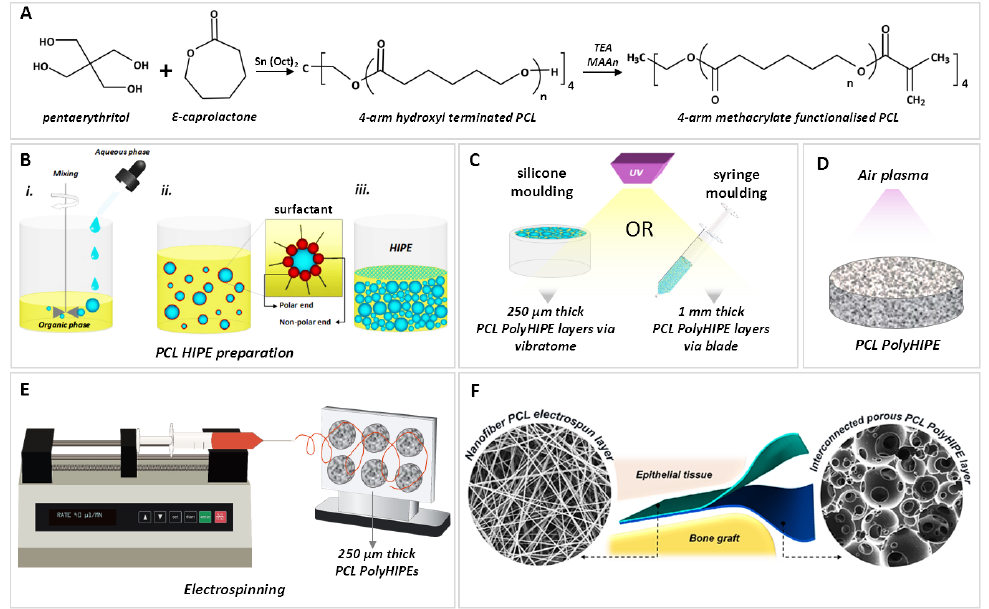
Figure 1. Summary of the manufacturing process of the bilayer membrane. ( A ) Synthesis of 4-arm hydroxyl-terminated polycaprolactone (PCL) and methacrylate terminalisation reaction ( B ) PCL polymerised high internal phase emulsion (polyHIPE) preparation process, ( C ) the polymerisation of PCL HIPEs to obtain PCL polyHIPE and slicing the samples, ( D ) air plasma treatment of PCL polyHIPE, ( E ) electrospinning of PCL on 250 µ m thick PCL polyHIPE layer, ( F ) final representation of the bilayer barrier membrane